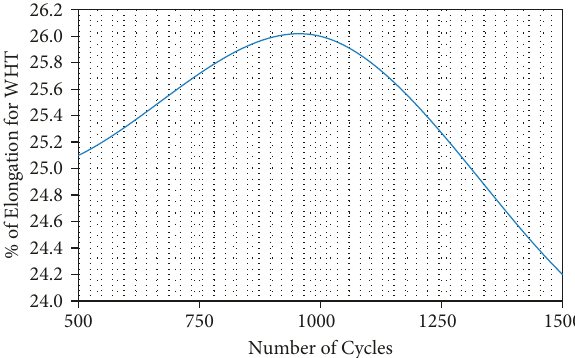
Figure 9: % of elongation of